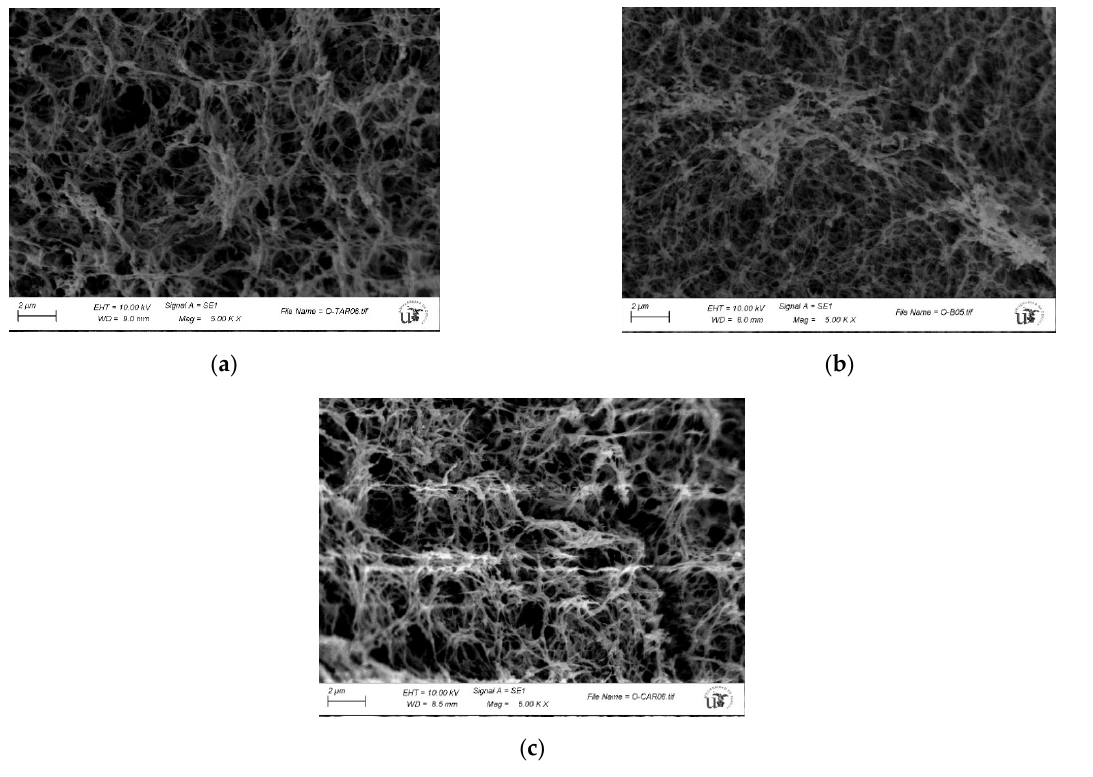
Figure 10. ( a ) SEM photo from GG ‐ p(TAR 50 B 50 ). ( b ) SEM photo from GG ‐ pB. ( c ) SEM photo from GG ‐ p(CAR 50 B 50 ). GG-p(CAR 50 B 50